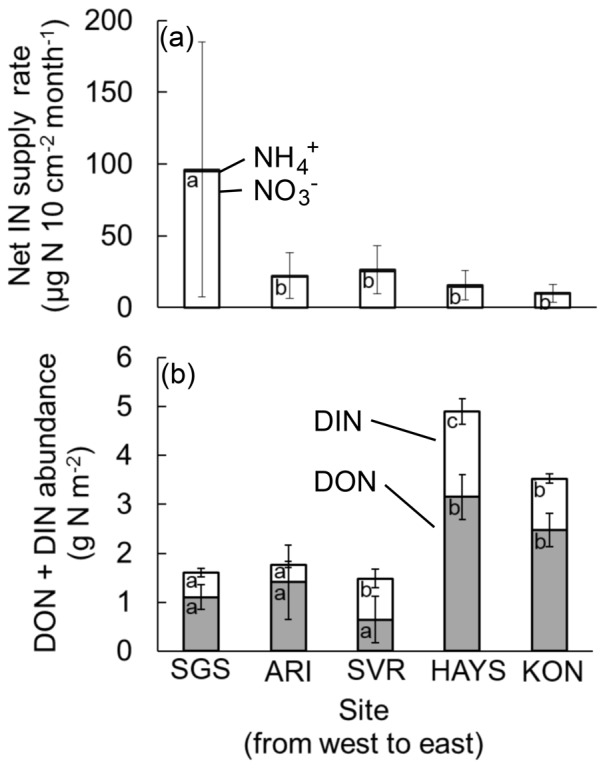
Inorganic N supply rates and extractable dissolved N pools at grassland sites.a) 0–5 cm soil net inorganic N supply rates (NH4
+ in black bars, NO3
− in white bars) at five grasslands of the US Great Plains, arranged from west to east. Error bars represent 95% confidence intervals on total (NH4
++NO3
−) inorganic N supply rate. Lowercase letters represent significant site differences at α = 0.05. b) Total extractable dissolved soil N (DIN+DON) to 10 cm soil depth across the US Great Plains. Lowercase letters in the gray columns represent significant differences in DON among sites; lowercase letters in the white columns indicate significant differences in DIN among sites. Multiple comparisons were performed on output of ANOVAs that did not include soil moisture as a covariate. Error bars represent 95% confidence intervals. Significance assessed at α = 0.05. One extreme outlier (DON>17 g N m−2 at SVR) was excluded from the analysis.